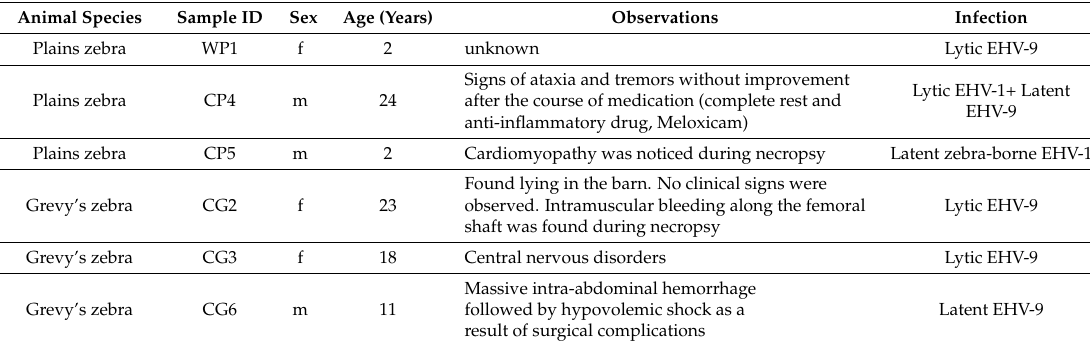
Table 1. List of positive animals tested in the study and virus infection